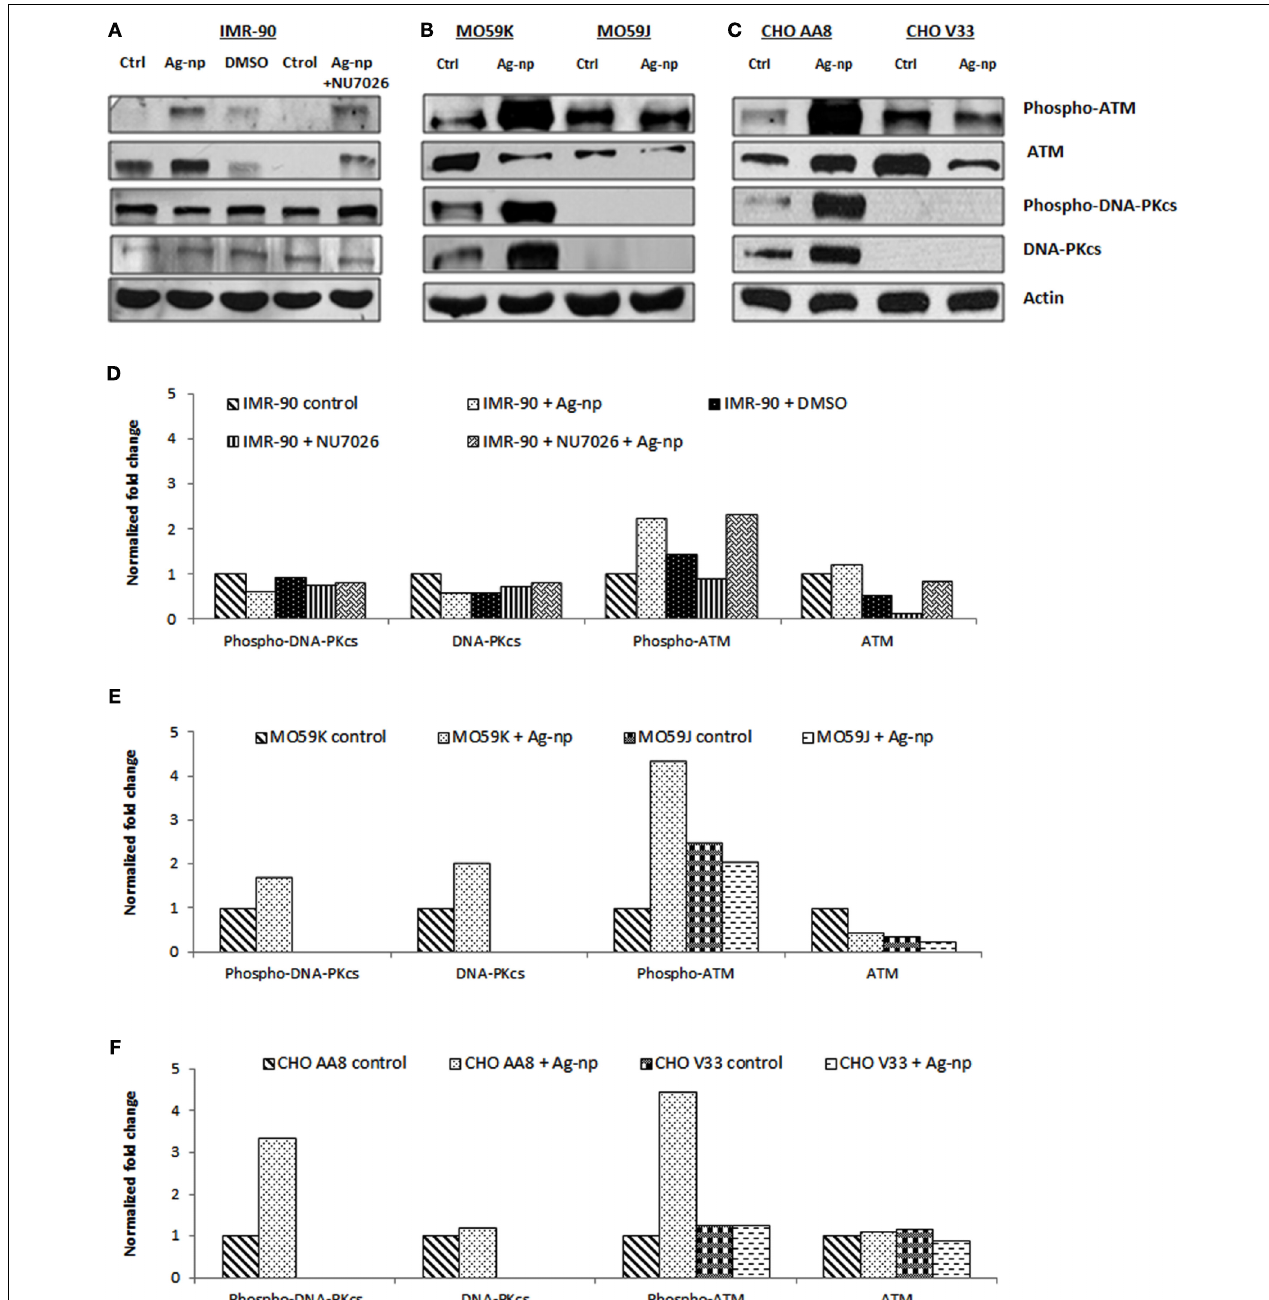
(D–F) Fold change for protein levels were obtained by densitometry analysis of X-ray films using Kodak molecular imaging software and normalized against actin levels to represent accurate values for proteins which deviated from the